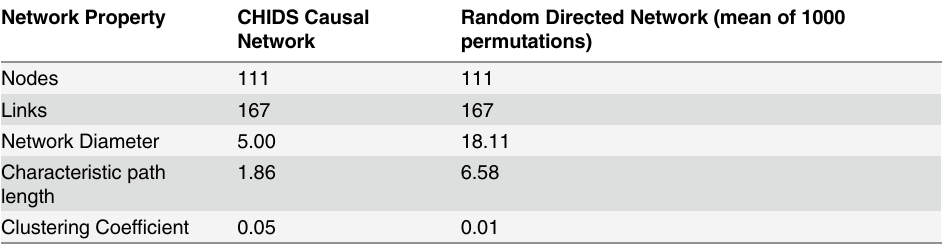
Table 2. Properties of the CHIDS Causal Network vs. Random Directed